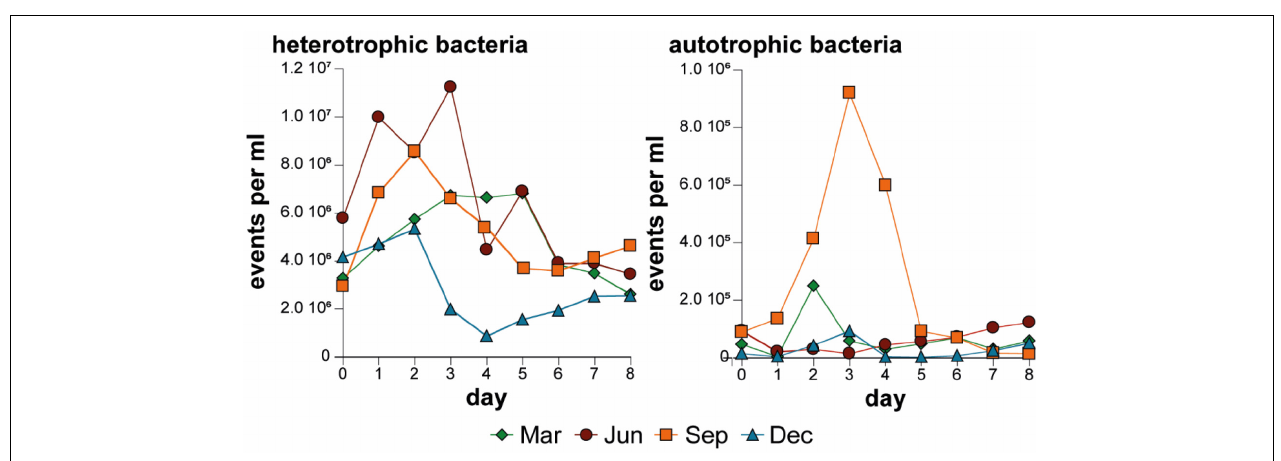
FIGURE 4 | Development of heterotrophic and autotrophic bacteria (median of triplicate experiments) in the “1.2 µ m” treatment over the four experiments.